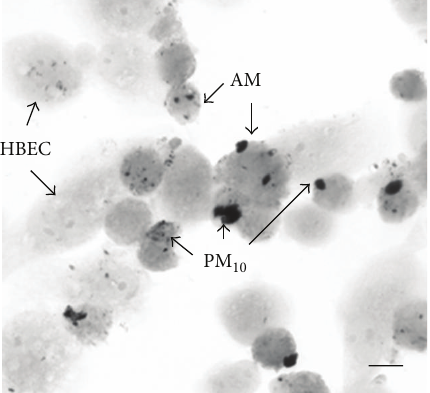
Figure1:Photomicrographofcoculturedprimaryhumanbronchial epithelial cells (HBECs) and human AMs incubated with 100 𝜇 g/mL of PM 10 (EHC-93) for 24 h showing particles internalized by both HBECs and AMs. Cells were cocultured on coverslips, and immunocytochemistry was performed using mouse anti-human CD68 monoclonal antibody to identify AMs. The bar represents 10 𝜇 m [54].